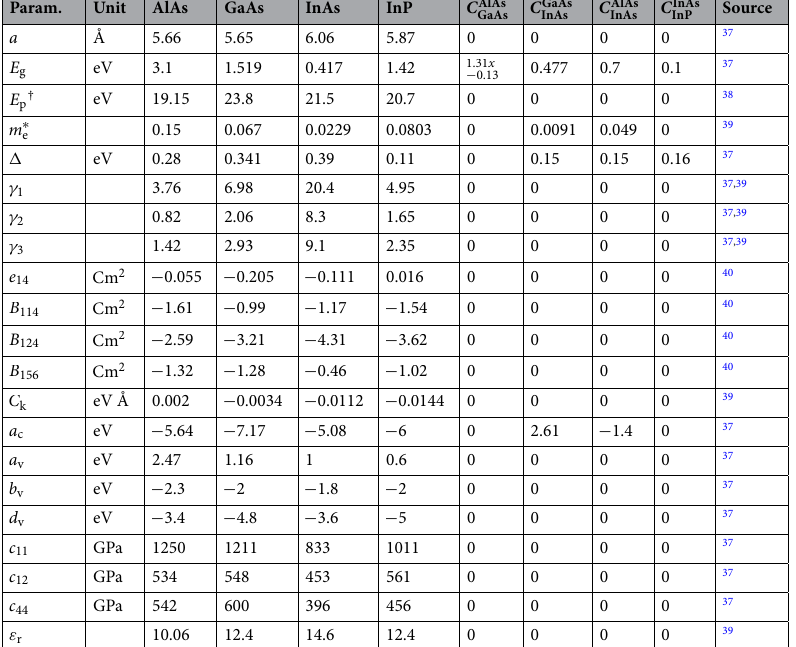
Table 1. Material parameters used in the modeling of nanostructures and calculation of single-particle and exciton states. † Values used for optical properties; for the